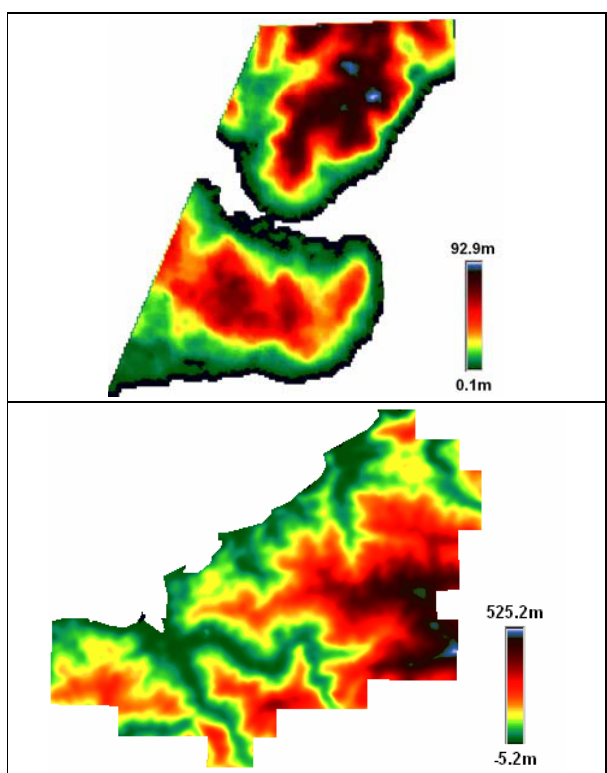
Figure 5. Color coded ASTER GDEM